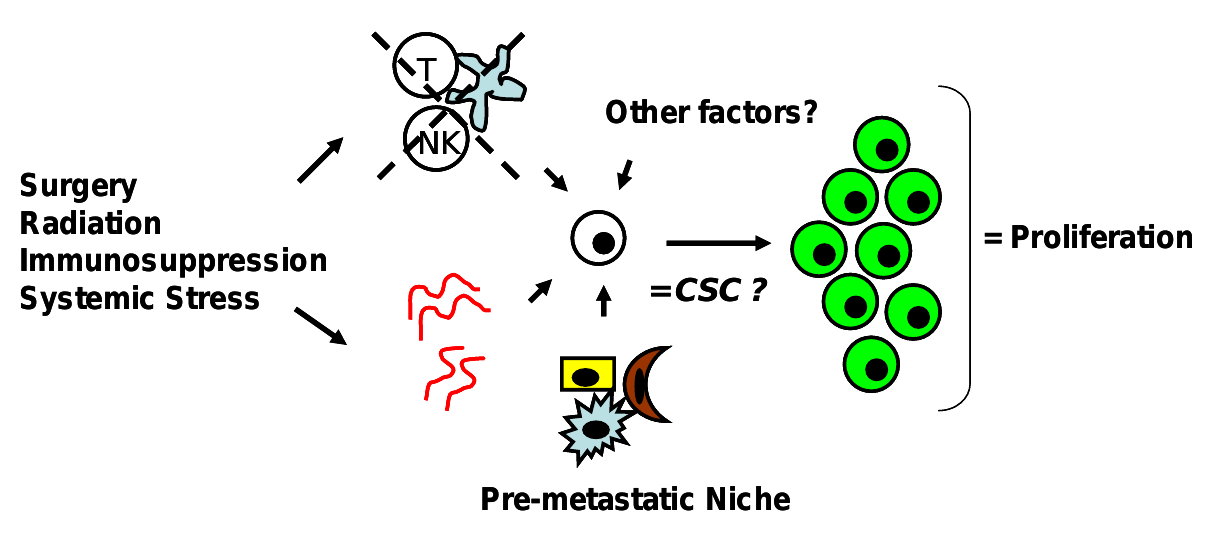
Figure 2. Surgery and other stimuli may affect angiogenesis and immune regulation, which in combination with other local microenvironment factors (e.g., pre-metastatic niche cells), promote escape from tumor dormancy leading to tumor cell proliferation (green). The relationship of dormant tumor cells to cancer stem cells (CSC) remains to be